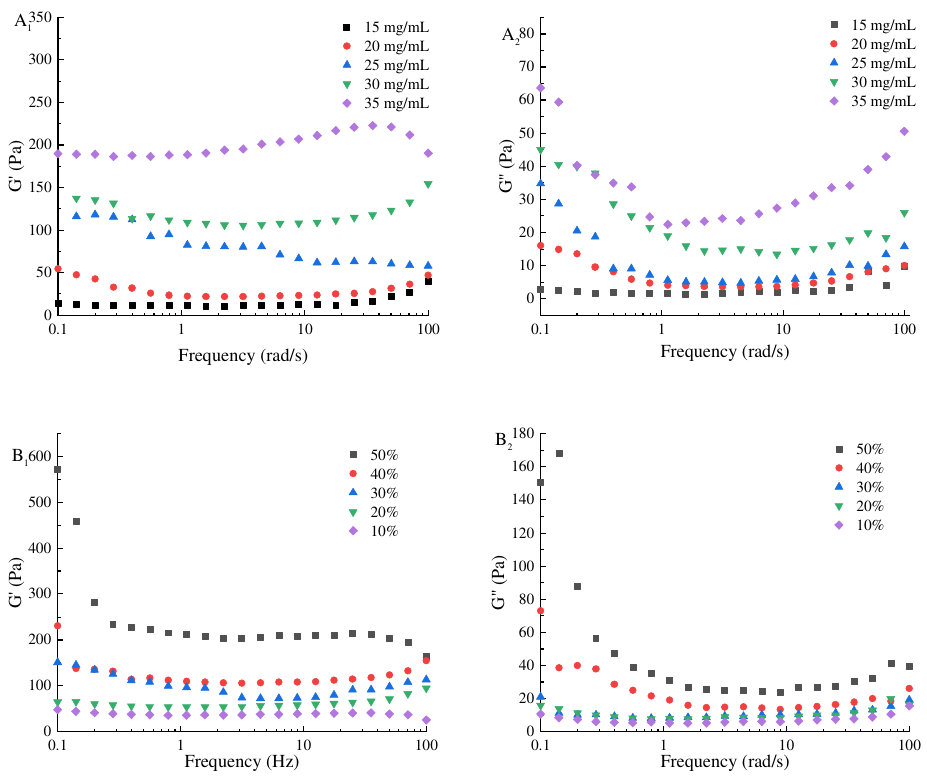
Figure 8. The influence of concentration of SPI and maltose ( A ) and oil phase volume fraction ( B ) on the rheological properties of the Pickering emulsion. ( A 1 ) was the G (cid:48) of Pickering emulsion prepared under different concentrations of SPI and maltose, ( B 1 ) was the G (cid:48) of Pickering emulsion prepared under different oil phase volume fraction, ( A 2 ) was the G (cid:48)(cid:48) of Pickering emulsion prepared under different concentrations of SPI and maltose, ( B 2 ) was the G (cid:48)(cid:48) of Pickering emulsion prepared under different oil phase volume fraction.).